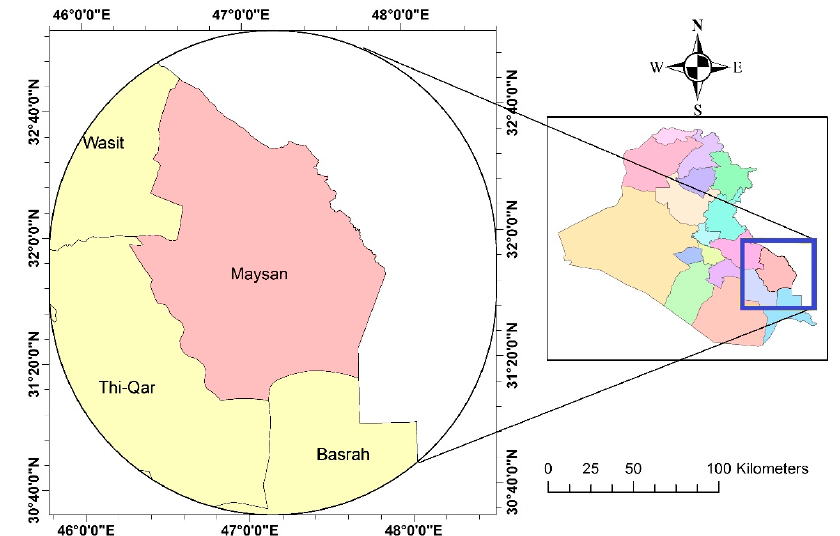
Figure 1. The study area location (Maysan province).